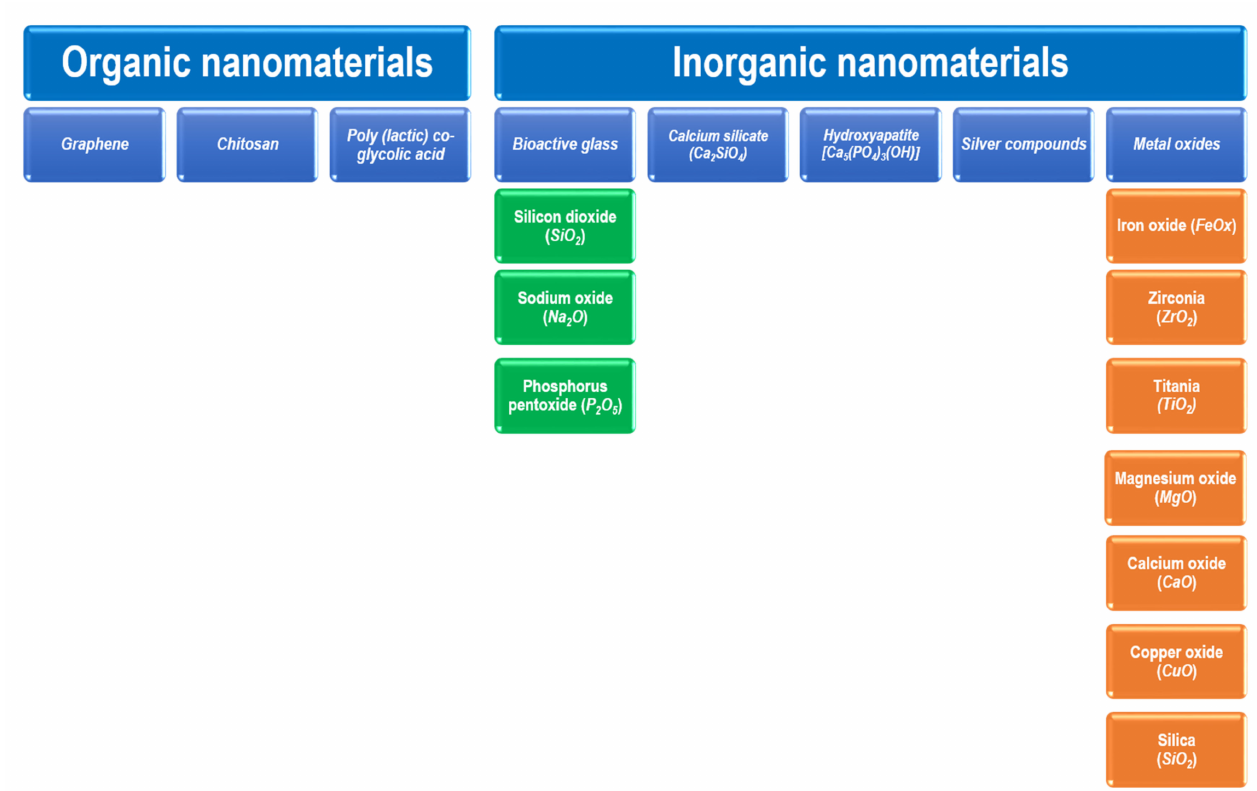
Figure 3. Types of nanomaterials employed in endodontic